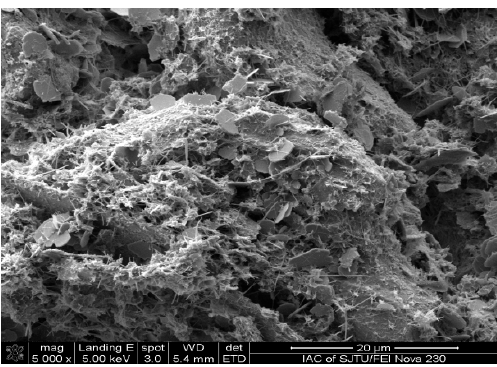
Figure 5. Microscopic appearance of the solidified calcareous sand.